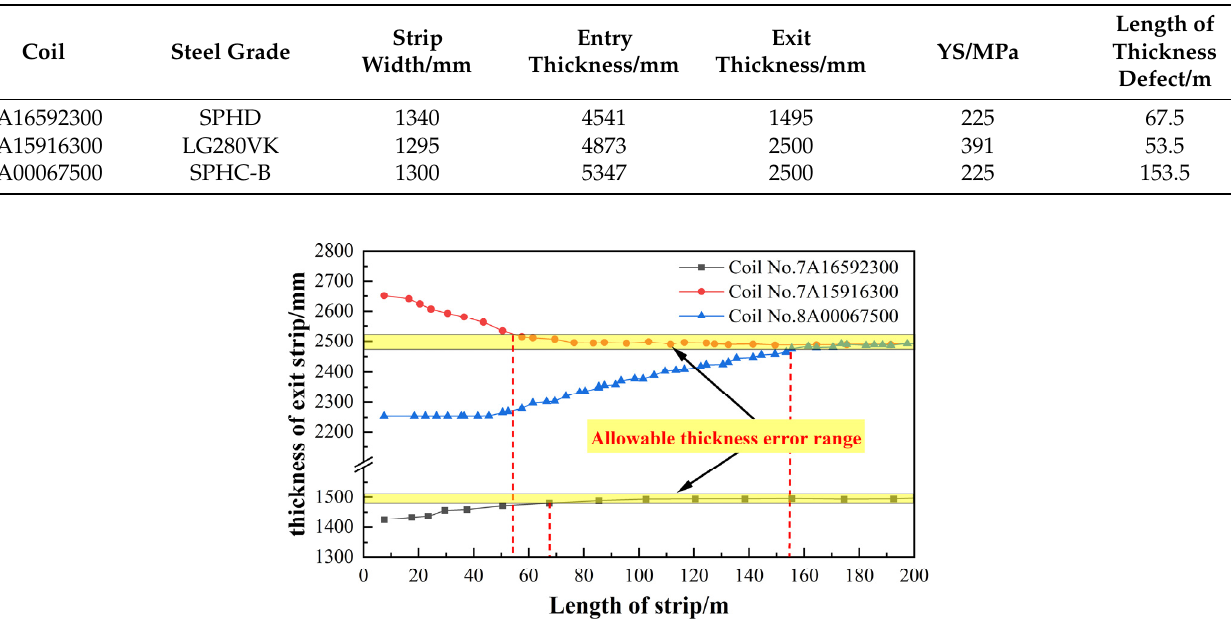
Figure 12. Thickness defect of the strip head before optimization. Table 4. The FGC strip before optimization.